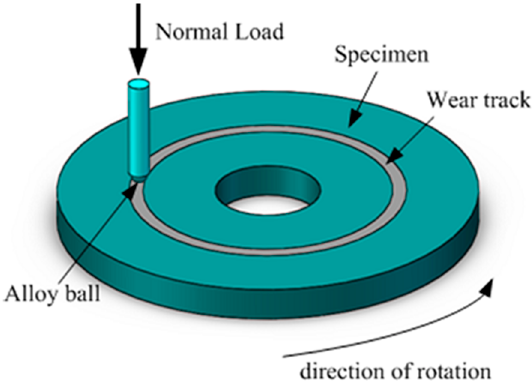
Figure 3. The schematic view of the working principle of the friction tester.